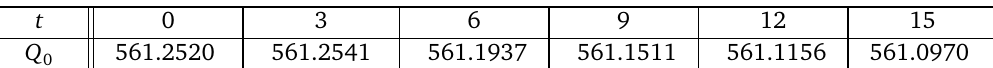
at several times. Here, the 0 q “ 7 and T “ 0 (no bath). To evaluate Q , we m a 0 is numer- 0